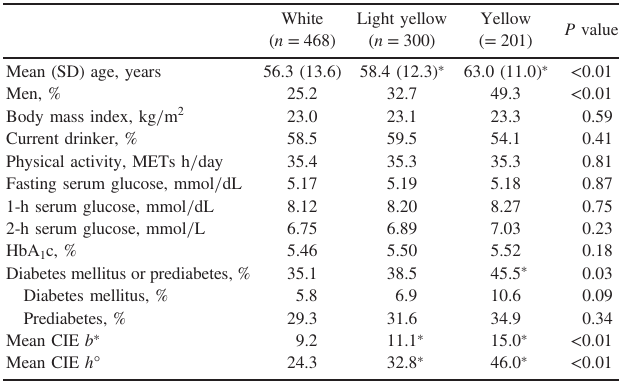
Table 1. Characteristics of participants according to tongue coating categories White